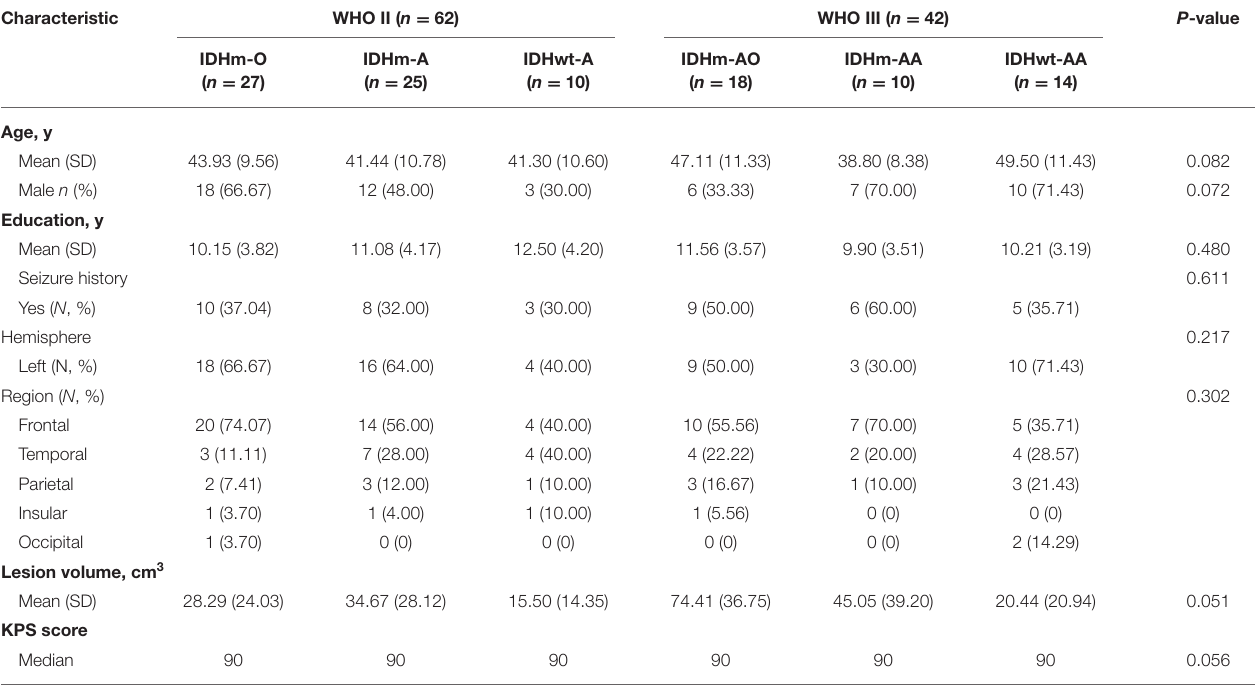
TABLE 3 | Clinical characteristics of molecular subgroups.